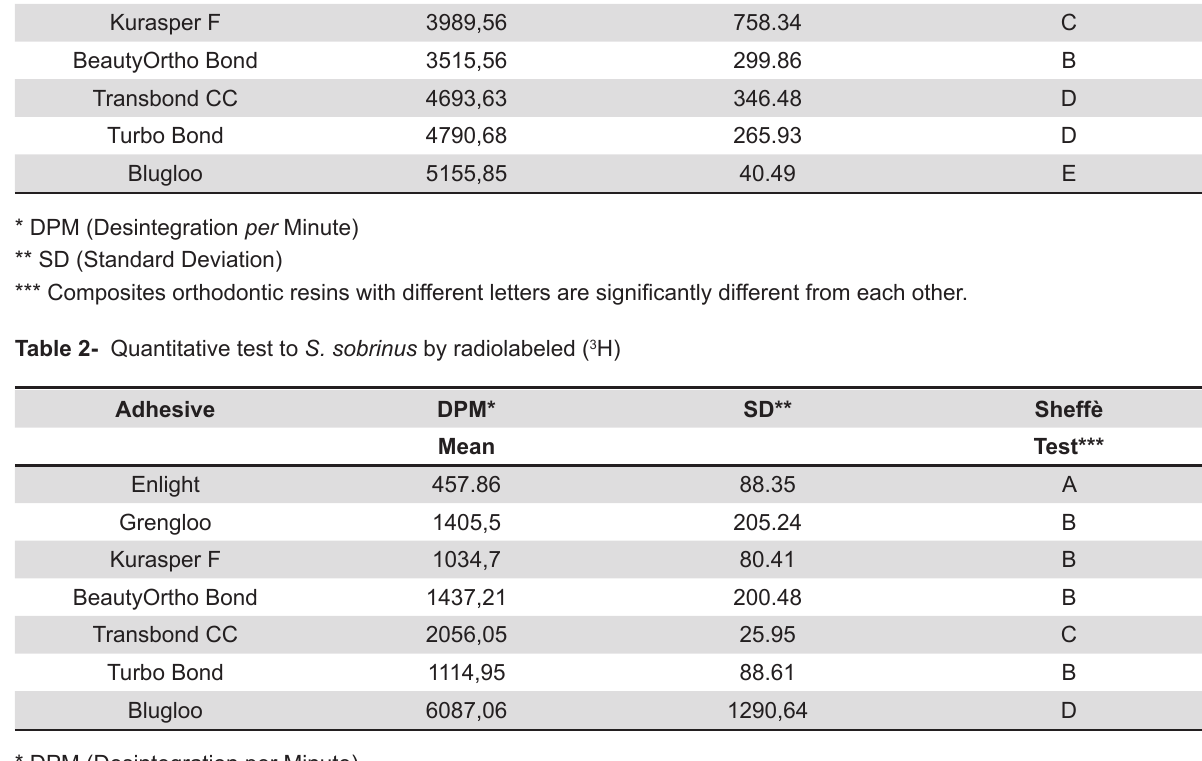
* DPM (Desintegration per Minute) ** SD (Standard Deviation) *** Composites orthodontic resins with different letters are significantly different from each